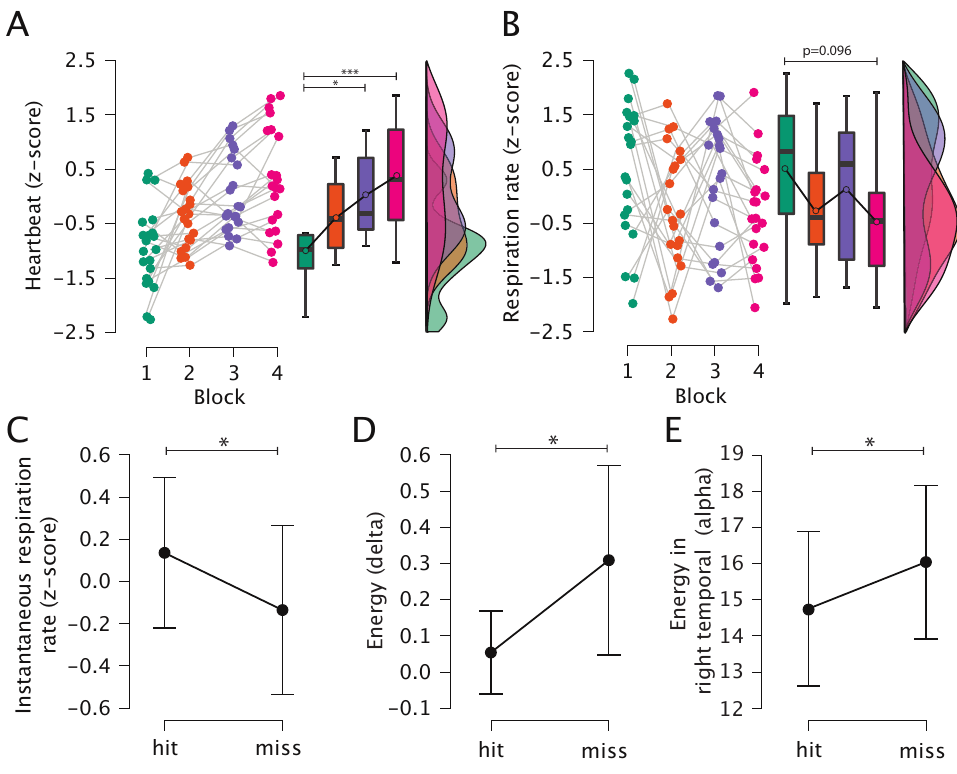
Figure 3. Results of the physiological data analysis: ( A ) Heartbeat at the rest phase (z-score); ( B ) Res- piration rate during the shooting phase (z-score); ( C ) Instantaneous respiration rate corresponding to the shot time for hit and miss; ( D ) Average energy value in delta range before the shot for hits and misses; ( E ) Average energy value in the right temporal lobe in the alpha range before the shot for hits and misses. Dots correspond to individuals subjects while box and whisker plots show values averaged over the blocks of the experiment. The symbol * denotes statistical significance in post hoc analysis using t-test with Holm’s correction for multiple comparisons (*— p < 0.05, ***— p <